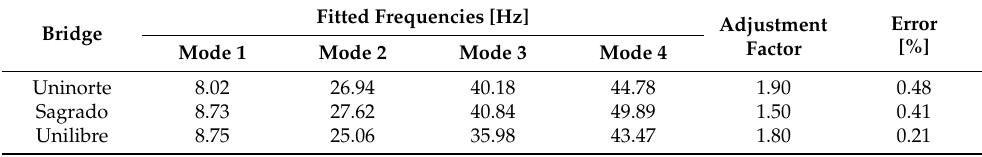
Table 7. Fitted frequencies associated with the first four vertical vibration modes in [Hz].